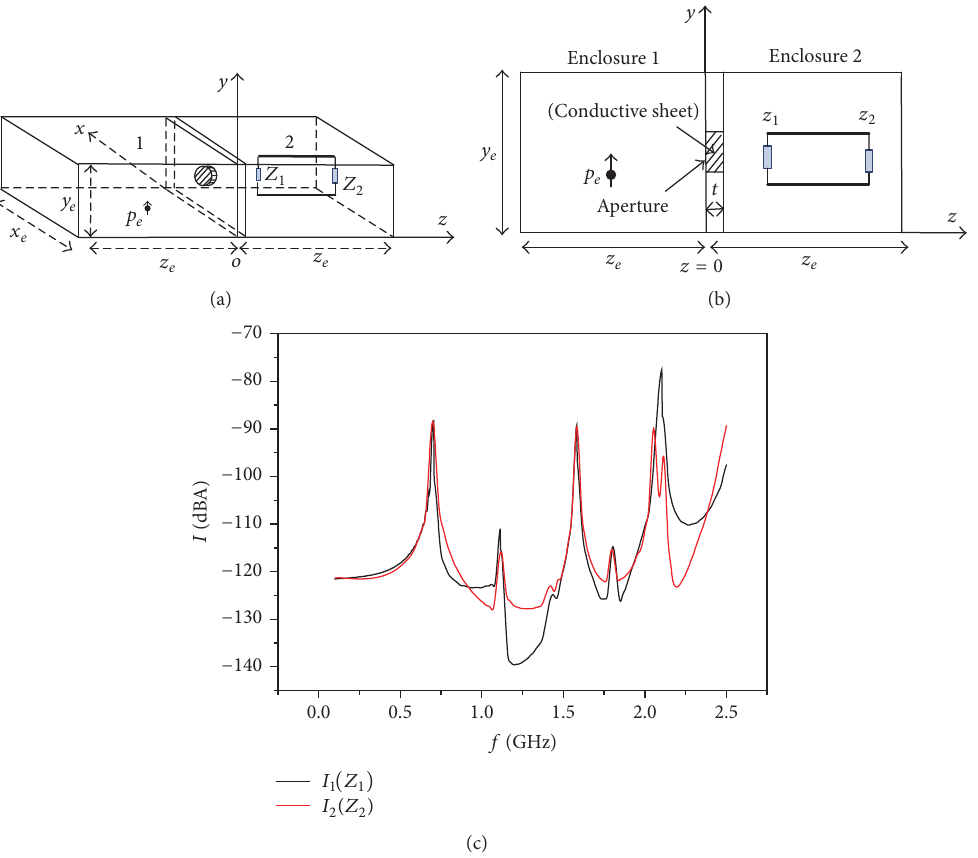
Figure 10: (a) The geometry of the enclosures with the TL oriented along the 𝑧 -axis. (b) The side view of the enclosures corresponding to (a). (c) The electric current induced at the termination loads 𝑍 1 and 𝑍 2 for the TL oriented along the 𝑧